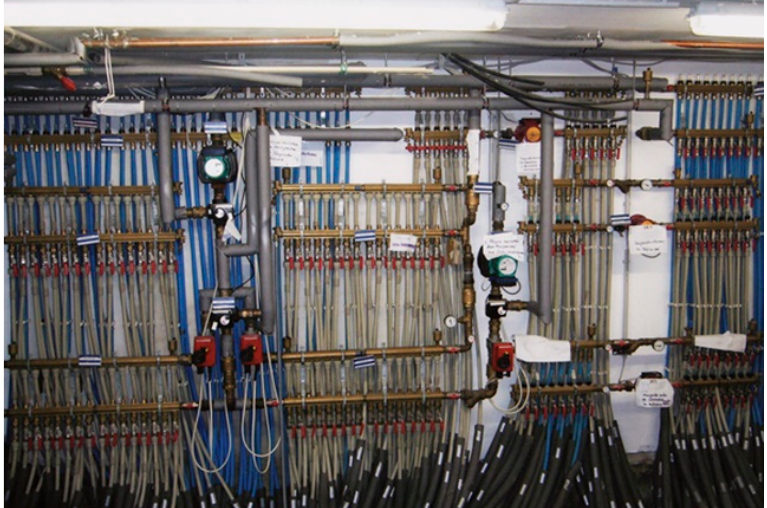
Figure 7. ISOMAX system control [1,2] .